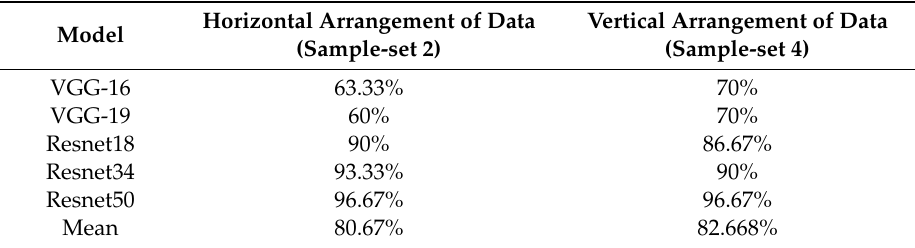
Table 12. Test accuracy for di ff erent classification